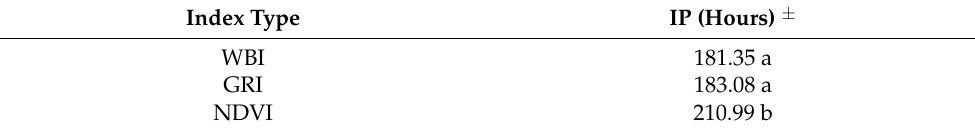
Figure 2. Four-parameter nonlinear logistic regression model fits to spectral reflectance gathered from two grass species, creeping bentgrass (CBG) and hybrid bermudagrass (HBG), grown in three soil textures, USGA 90:10 sand (S), loam (L), and clay (C) subjected to drought stress under greenhouse conditions in Blacksburg, VA. The water band index (WBI = R 900 /R 970 ) and green-to-red ratio (GRI = R 550 /R 670 ) are shown by grass species ( a , c ), and soil type ( b , d ) on the top and bottom, respectively. Table 3. Mean hours of inflection points (IP) for three vegetation indices based on light reflectance data collected from creeping bentgrass and hybrid bermudagrass grown in three soil textures and subjected to drought stress under greenhouse conditions in Blacksburg, VA across six dry-down cycles. Means followed by the same letter are not significantly different based on the students’ t -test ( α =